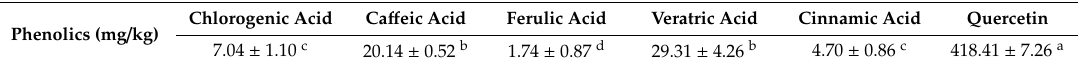
Table 3. HPLC analysis of phenolics extracted from A. dioicus